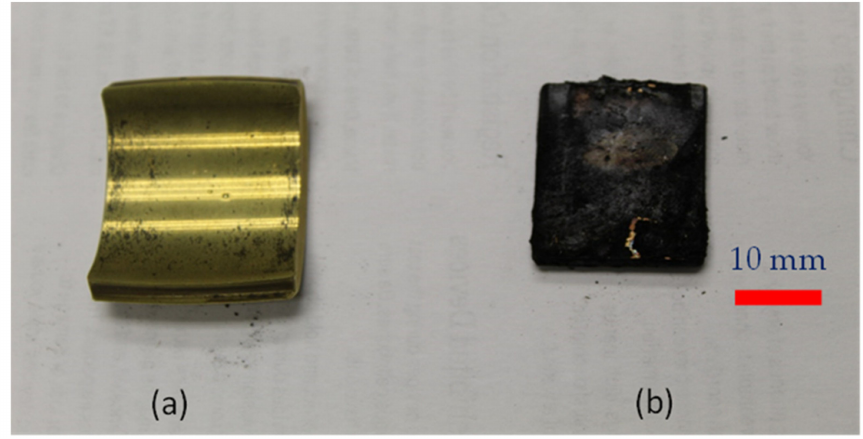
Figure 2. Photos showing the surface of uncoated ( a ) and hydrothermally coated brass ( b